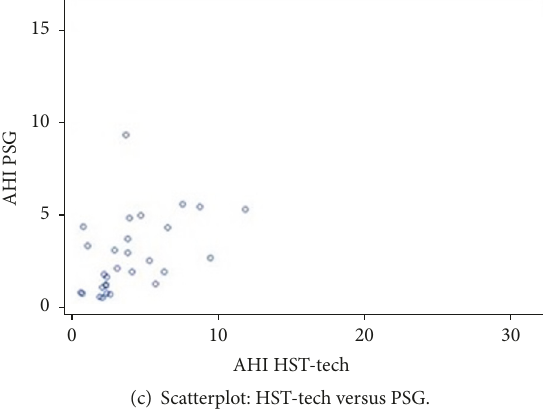
19 (79.2%) were also negative by HST-tech. The discordant negative studies are listed in Table